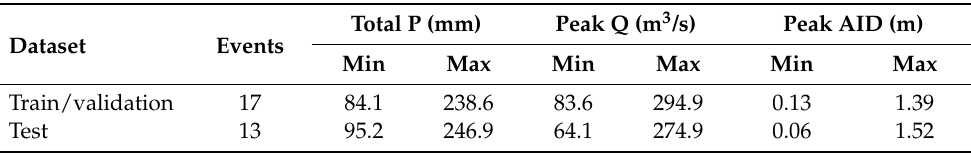
Table 2. Events characteristics.